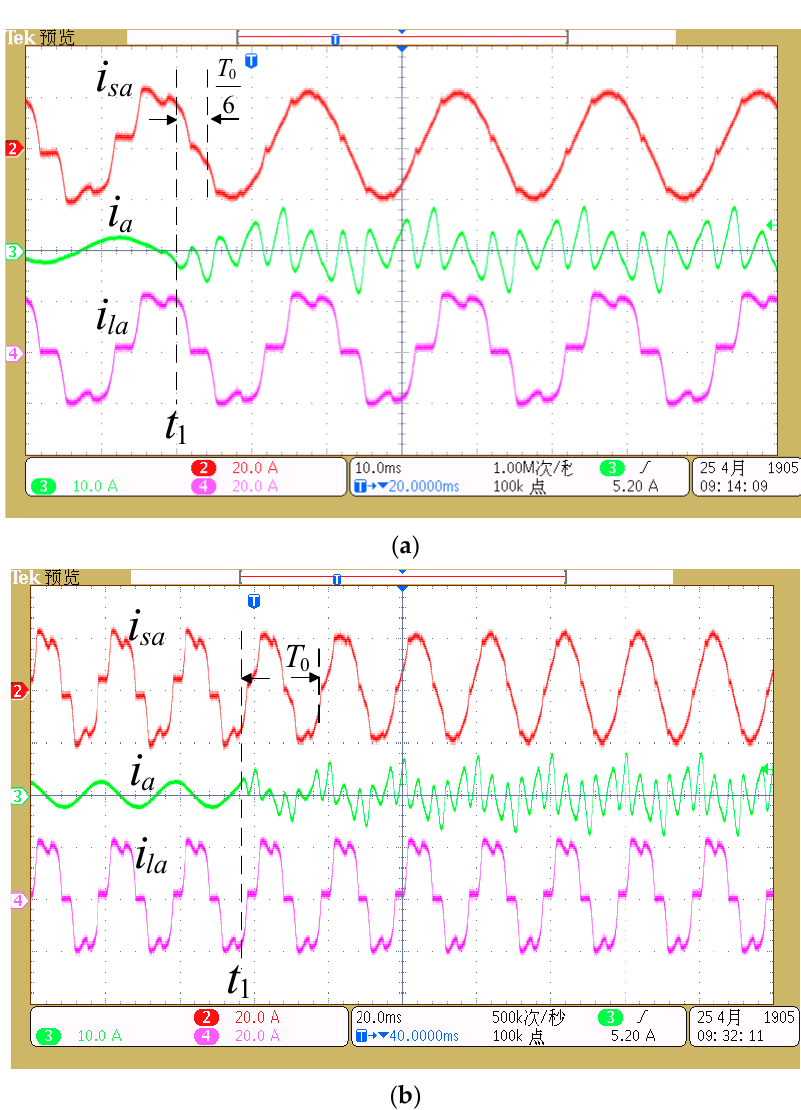
Figure 14. Dynamic performance comparison: ( a ) 6 k + 1 repetitive control scheme; ( b ) Traditional repetitive control scheme.